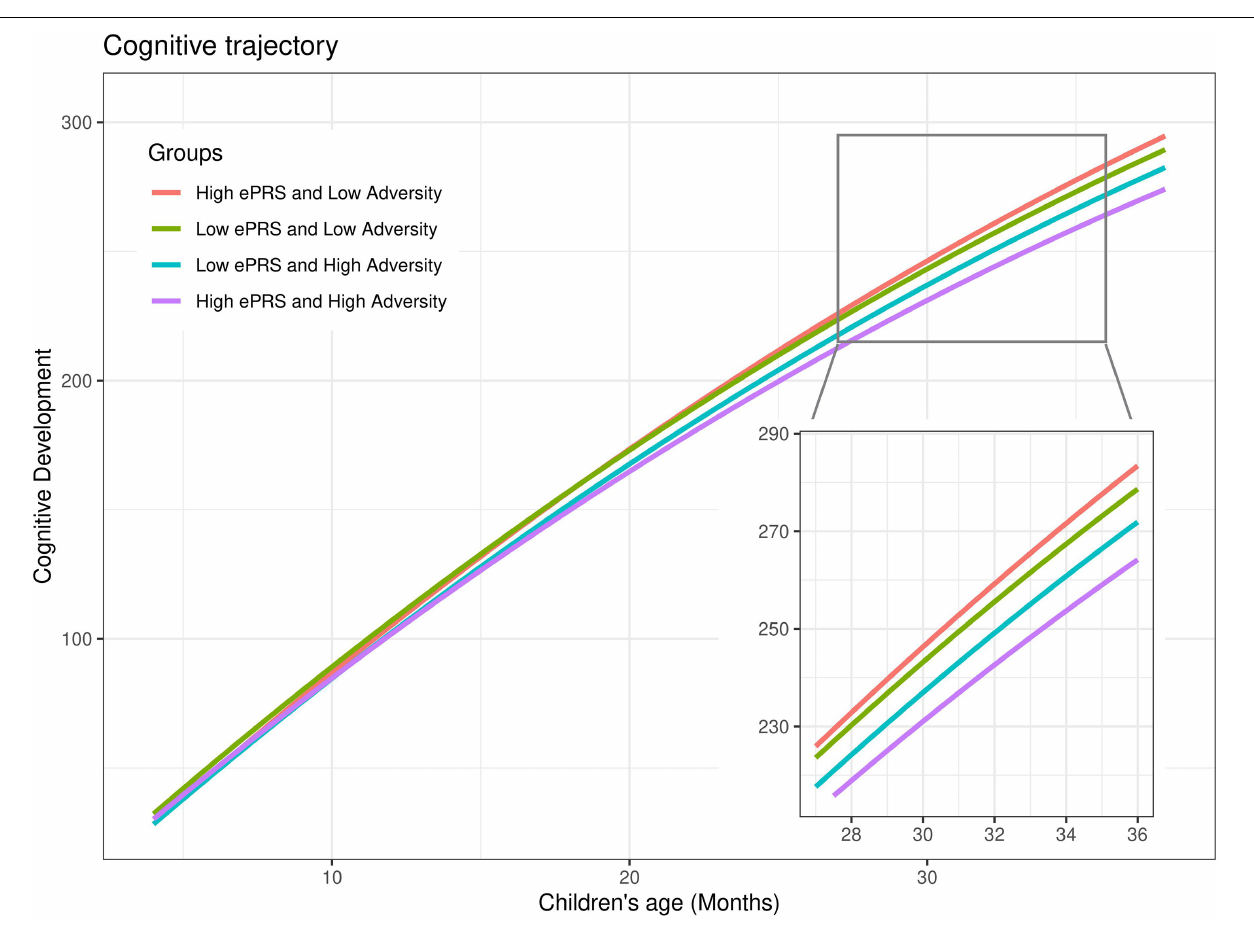
FIGURE 3 | Cognitive developmental growth as function of age, BDNF gene network and cumulative prenatal adversity. Predicted estimates of cognitive development were plotted considering high (+ 1SD) and low (–1SD) BDNF ePRS and high (+ 1SD) and low (–1SD) prenatal adversity for sake of the interaction visualization. Prenatal adversity effects on cognitive development trajectories are larger for children with high BDNF ePRS scores (red vs purple lines) in comparison with children with low BDNF ePRS scores (green and blue lines).